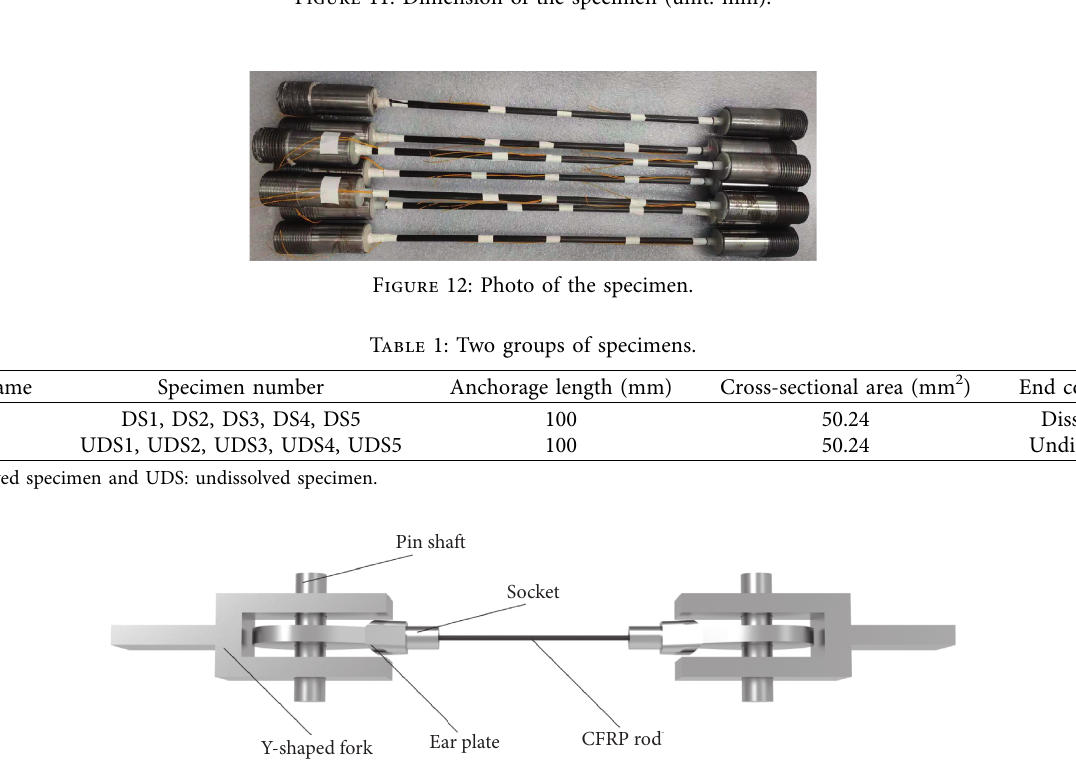
Figure 13: Specimen assembled with connection toolings.